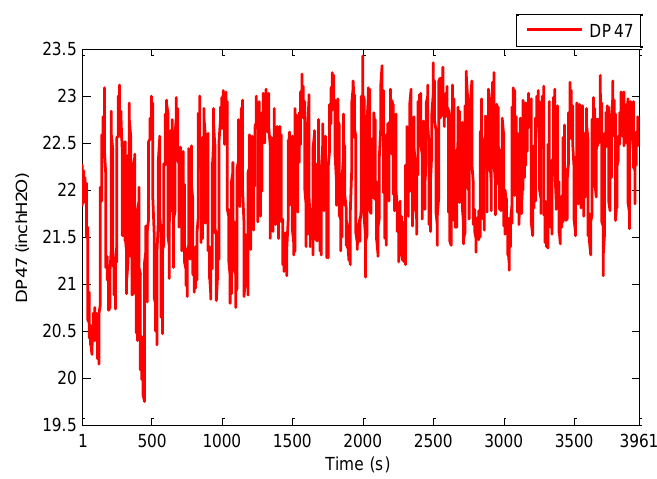
Figure 6. PRBS test - Output DP47 (inch H 2 O).